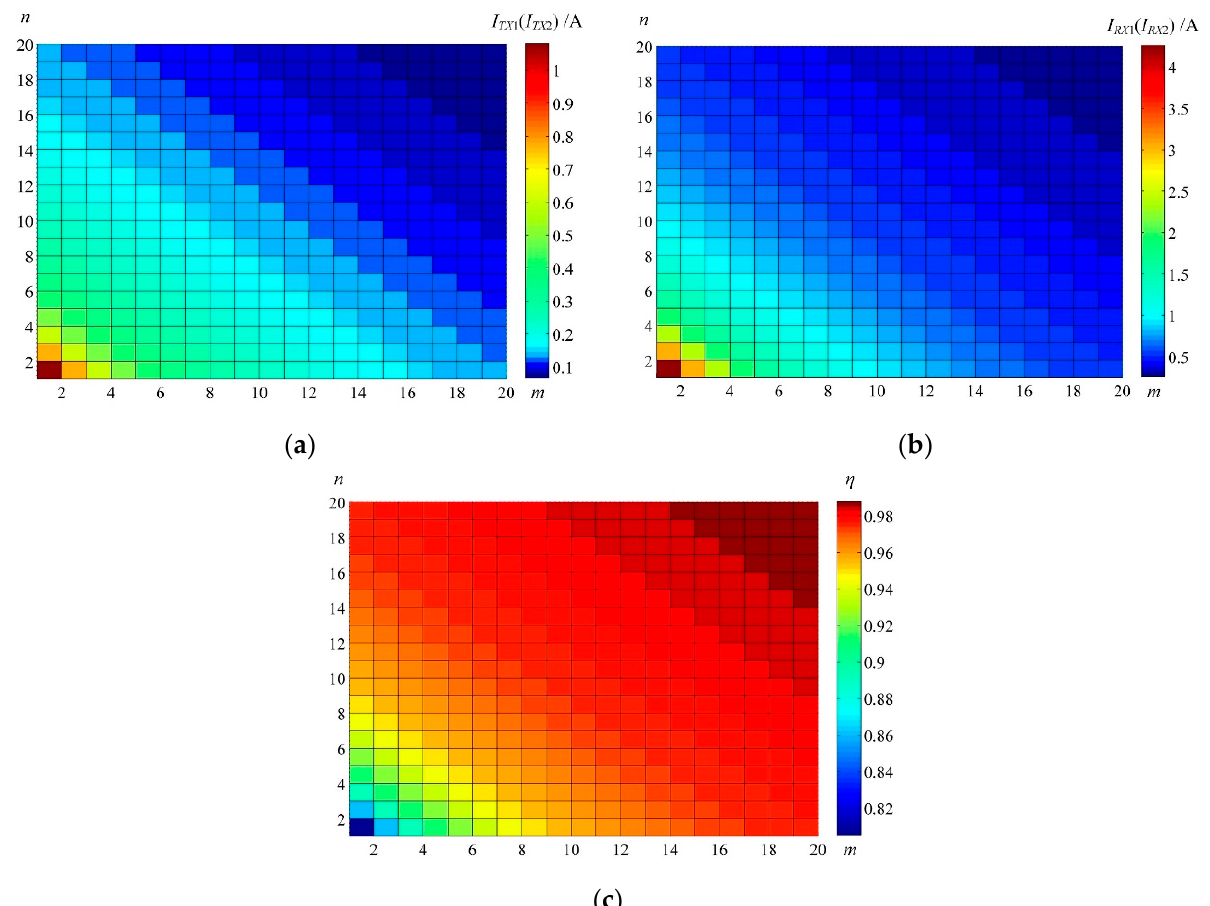
Figure 6. ( a ) The relationship between I TX and m , n . ( b ) The relationship between I RX ( P ) and m , n . ( c ) The relationship between η and m , n .